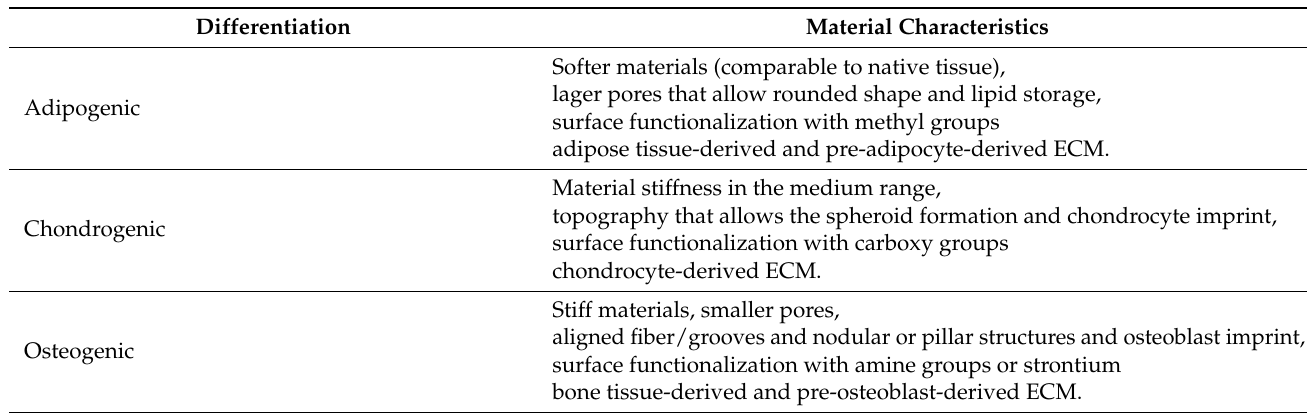
Table 7. Overview of material characteristics that support adipogenic, chondrogenic, and osteogenic differentiation of